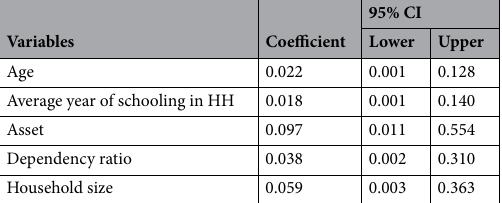
Table 2. Estimated parameters (with 95% CI) of geo-additive model for non-linear effects on the household level food